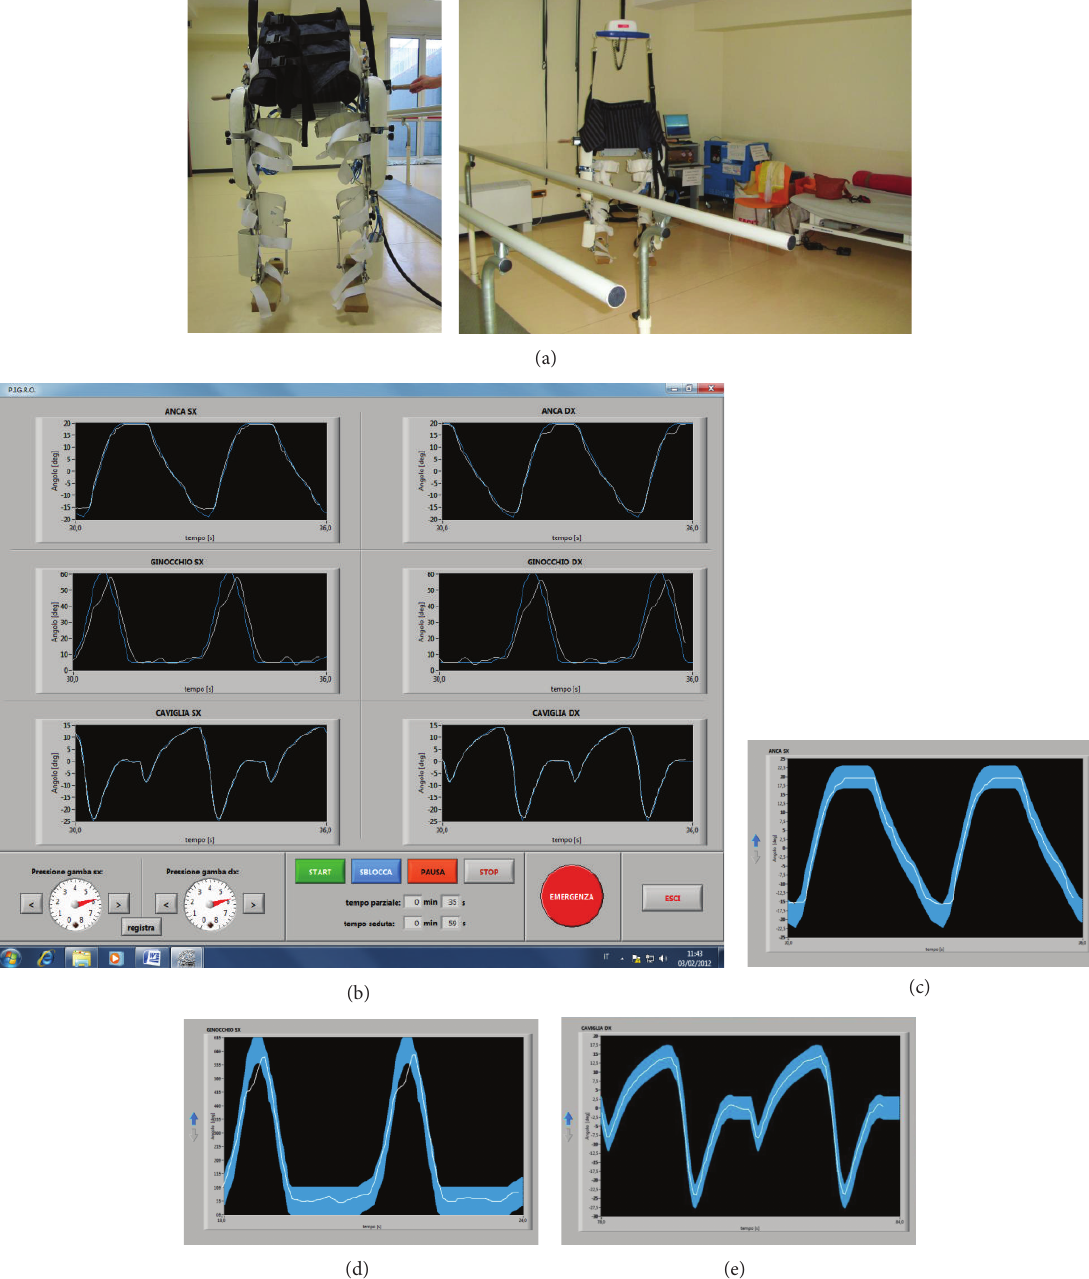
Figure 6: (a) P.I.G.R.O. in a rehabilitation center. ( b) P.I.G.R.O. operator’s monitor screenshot with the six joints visualized. ((c),(d), and (e)) Examples of biofeedback monitor screenshots for hip (c), knee (d), and ankle